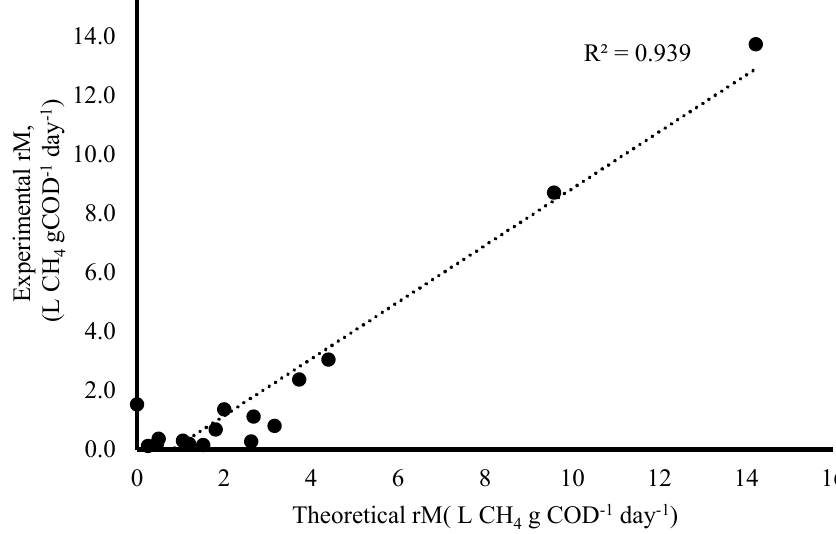
Figure 10. Experimental r M . versus theoretical r M .